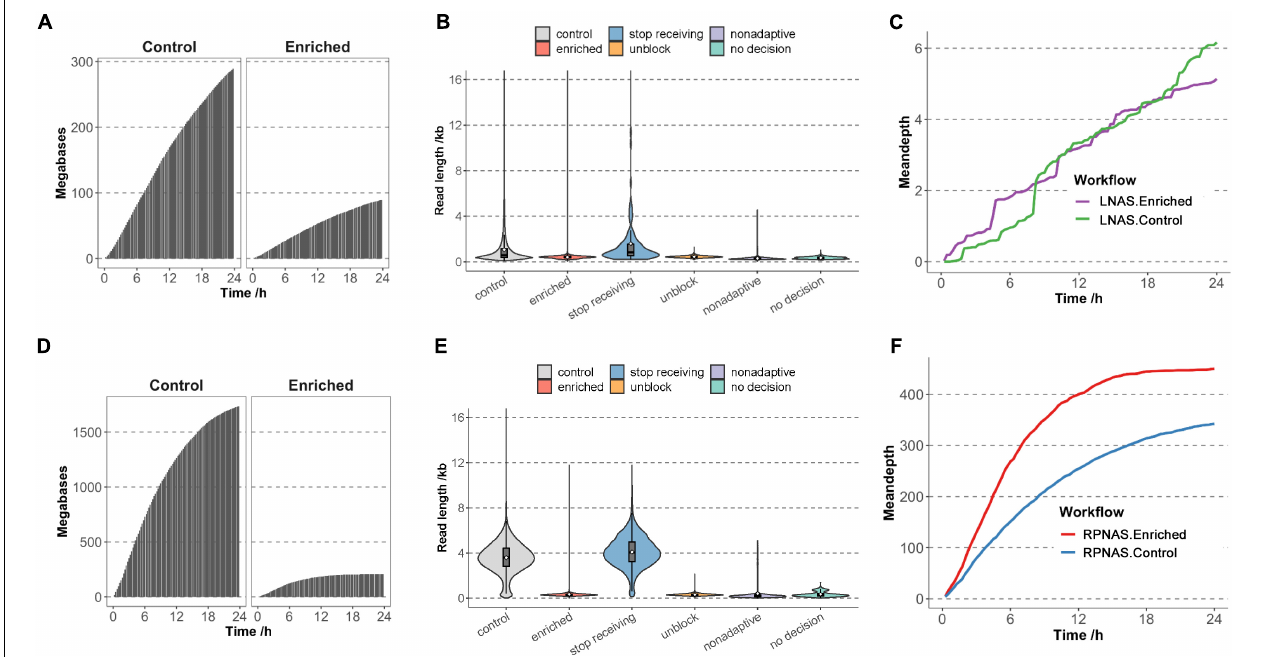
FIGURE 1 | Adaptive sequencing performance of the ligation-based nanopore adaptive sequencing (LNAS) and rapid PCR-based nanopore adaptive sequencing (RPNAS) workflows. The cumulative total base yield in the enriched and control groups over 24 h sequencing of sample M9 with the LNAS workflow (A) and sample HB204 with the RPNAS workflow (D) . The read length distribution of sample M9 with the LNAS workflow (B) and sample HB204 with the RPNAS workflow (E) . Reads in both the enriched and control groups were represented with red and gray colors, separately. Blue, orange, purple, and green colors represent stop receiving, unblock, non-adaptive, and no decision, respectively. The white dot represents the mean read length of each decision. The mean depth of human adenovirus (HAdV) in both the enriched and control groups over 24 h sequencing of sample M9 with LNAS workflow (C) and sample HB204 with RPNAS workflow (F)